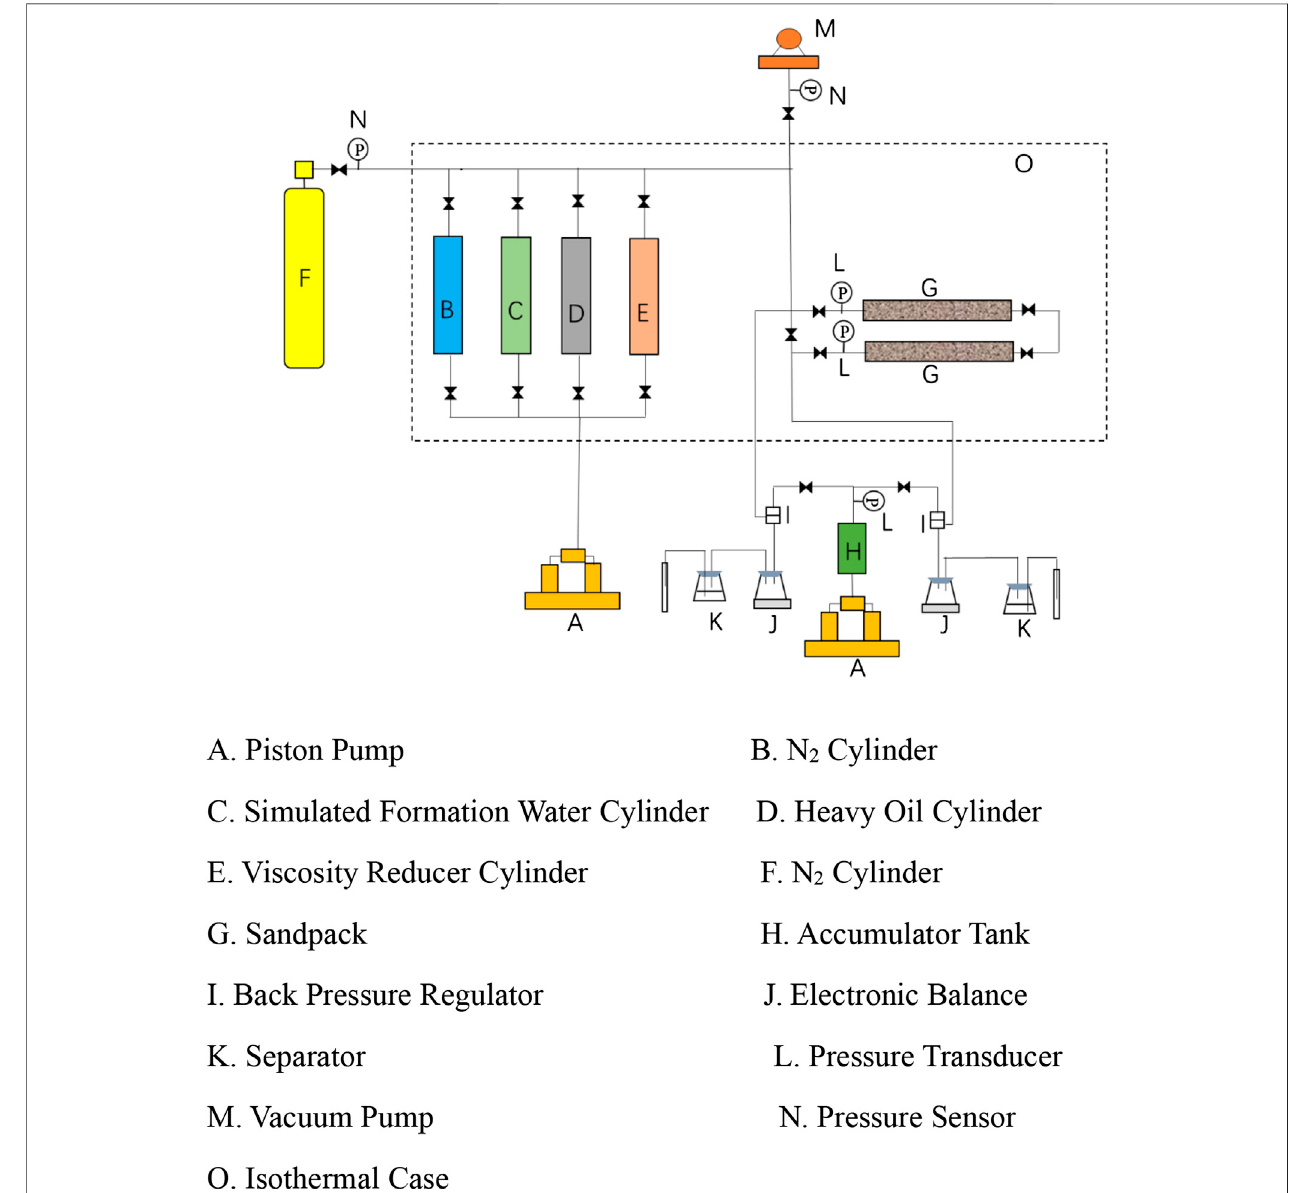
FIGURE 2 | Schematic diagram of the huff-n-puff